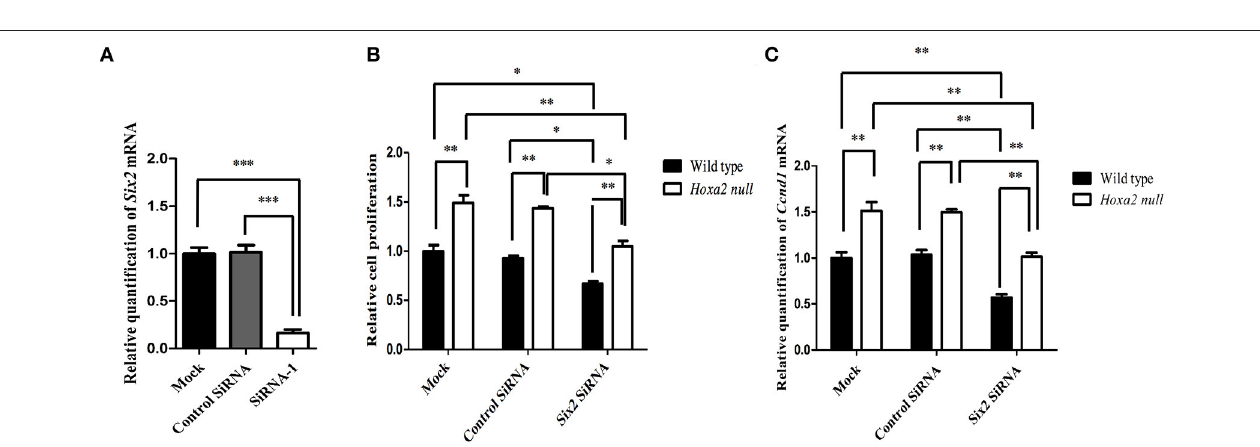
FIGURE 7 | Six2 knockdown in wild-type and Hoxa2 − / − mouse embryonic palate mesenchyme (MEPM) cultures reduces cell proliferation and Cyclin D1 expression. (A) Treatment of MEPM cultures with Six2 siRNA decreased Six2 mRNA expression by 90% compared to cultures administered either a negative control siRNA or siRNA delivery-vehicle alone (mock treatment). (B) Six2 siRNA treatment significantly decreased cell proliferation in both wild-type MEPM and Hoxa2 − / − MEPM cultures and also reduced expression of Cyclin D1 mRNA (C) . Note that levels of cell proliferation (B) and Cyclin D1 expression (C) in Hoxa2 − / − MEPM cultures were consistently higher than those of parallel wild-type cultures in all three treatment groups. Also, Six2 knockdown restored cell proliferation and Cyclin D1 expression in Hoxa2 − / − MEPM cultures to levels approximating those of control wild-type MEPM cultures. Bars represent mean ± SEM; n = 4 biological replicates. * p < 0.05, ** p < 0.01, *** p <